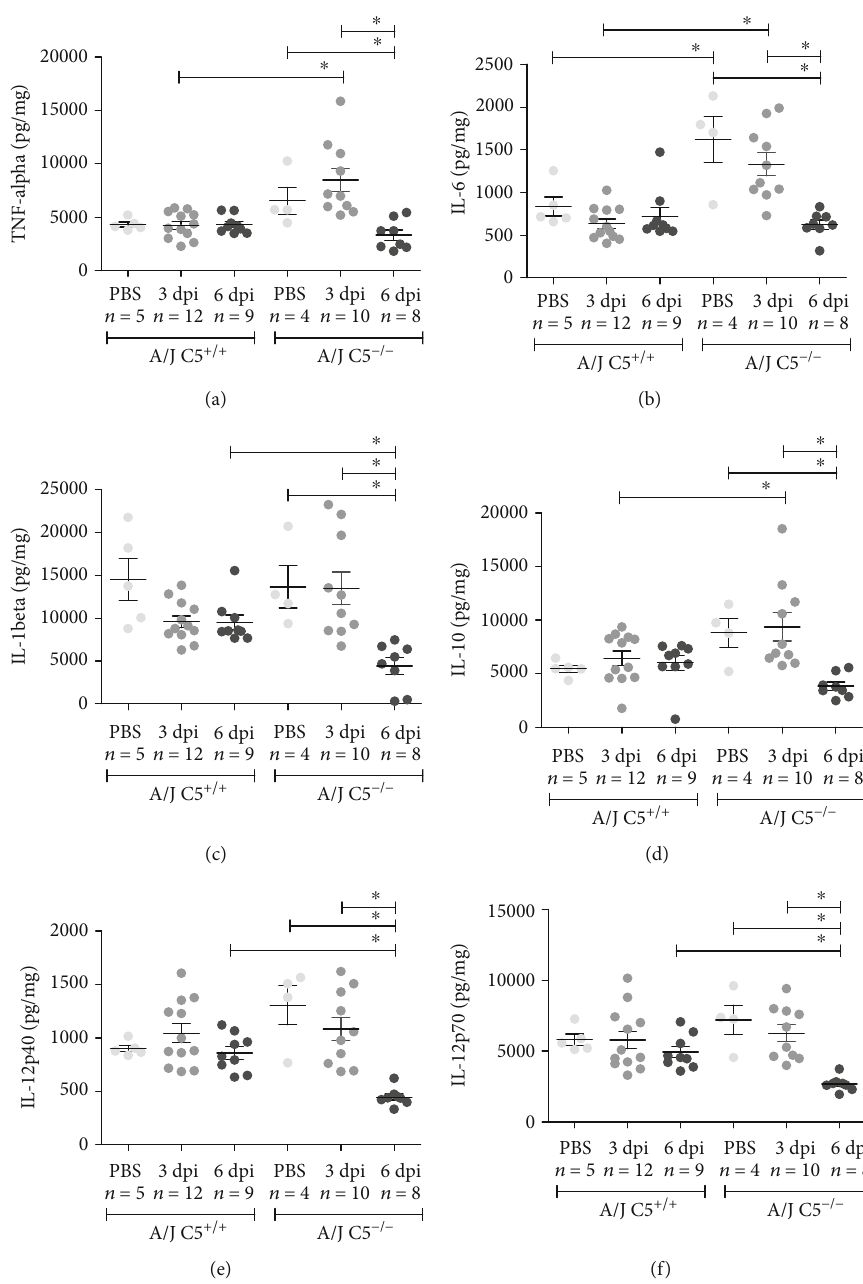
Figure 6: Kidney concentrations of pro- and anti-in fl ammatory cytokines during early infection by LPF. A/J C5 +/+ and A/J C5 -/- mice were inoculated i/p with 1 : 5 × 10 8 LPF or PBS and then euthanized on the third or the sixth days. The concentrations of several cytokines were analyzed in the liver extracts by ELISA, using the same protein concentration in each sample. Signi fi cant di ff erences are indicated as ∗ when p < 0 : 05 . dpi: days